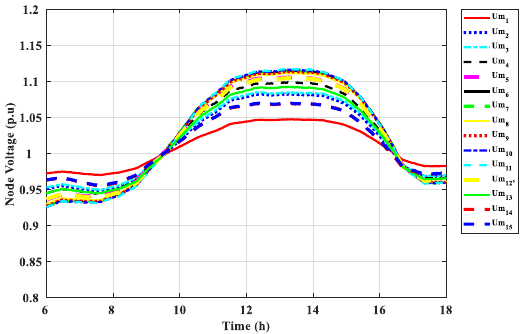
Figure 9. The voltage of the PV nodes without voltage control.